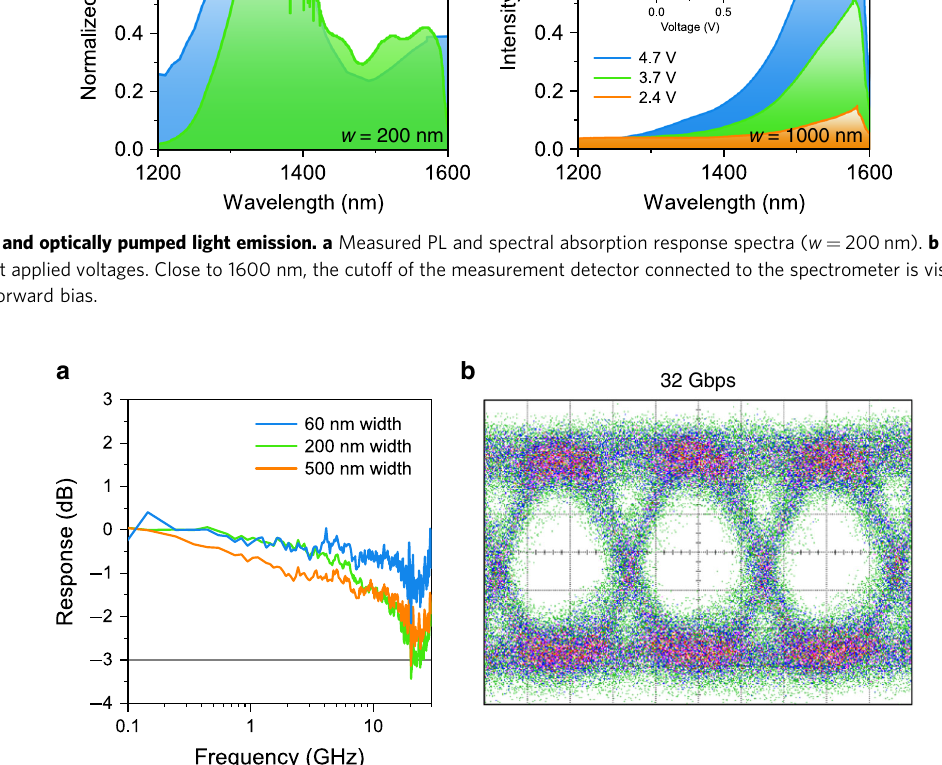
Fig. 6 High-speed data reception. a S 21 measurements for devices with different widths. The line at − 3 dB marks the 3 dB limit. b 32 Gb s − 1 eye diagram measured on a 500 nm wide device at − 2 V applied bias (1.5 mV div − 1 , 10 ps div − 1 ). Averaging was set to 128.